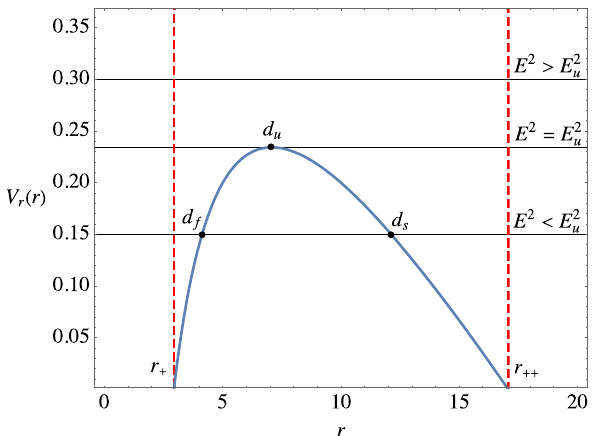
Fig. 3 The effective potential for radially moving massive particles plotted for γ = 0 . 04. In this particular case, the maximum distance of unstable orbit, is d u = 7 . 07 in accordance with E 2 = E 2 u = 0 . 23, and the two turning points d s = 12 . 3 and d f = 4 . 12 have been indicated in accordance with the corresponding value E 2 = 0 . 15. The point d s is related to the distance, at which, the particles 0 < E 2 < E 2 u ,